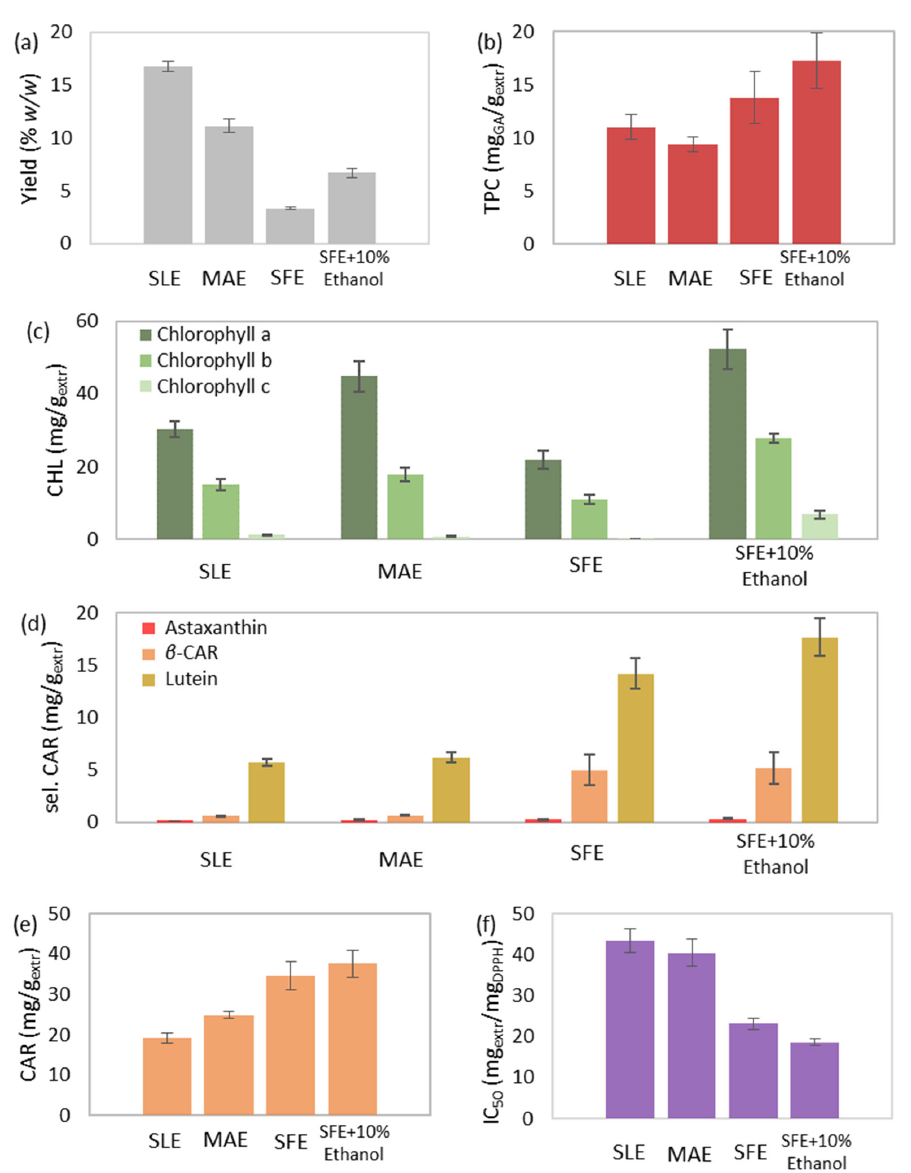
Figure 7. Comparison between the conventional solid ‐ liquid extraction (SLE), microwave ‐ assisted extraction (MAE), supercritical fluid extraction (SFE) and supercritical fluid extraction with 10% w / w cosolvent addition (SFE + 10% Ethanol) of Chlorella vulgaris , regarding the ( a ) extraction yield, total ( b ) phenolic and ( c ) chlorophyll content, ( d ) selected and ( e ) total carotenoid content, and ( f ) antioxidant activity.